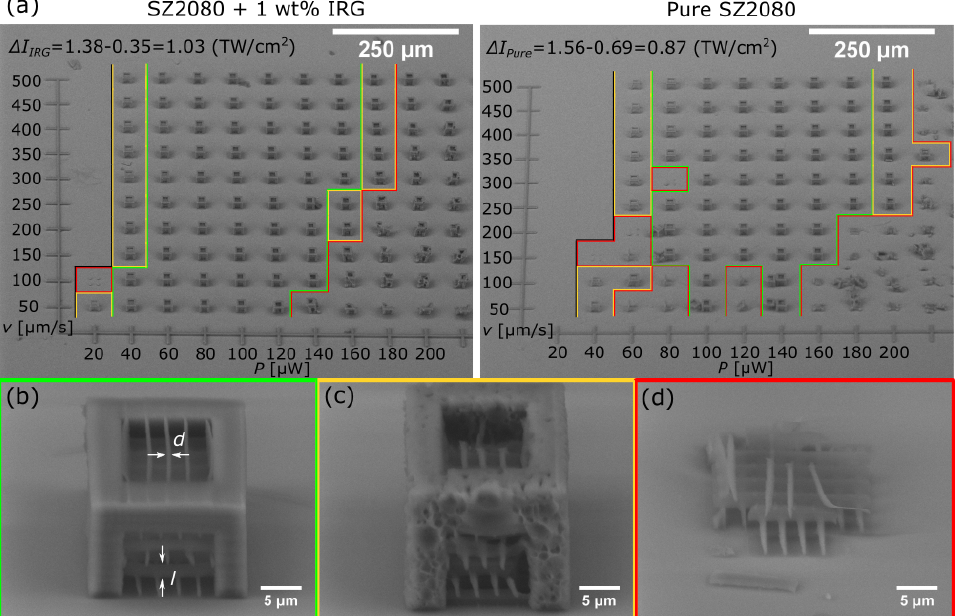
Figure 1. ( a ) SEM images of resolution arrays of photosensitized ( left ) and non-photosensitized ( right ) SZ2080. Structures with severe structural damage ( red ), with poor ( yellow ) and good ( green ) quality are outlined. The structure is considered good if internal single lines are observable and the shape of the cube is as designed. Average laser powers of the bottom and the top of the ∆ I are recalculated to the peak intensity I p (shown at the top); ( b ) one of the good quality structures in the array is shown in a greater detail; l and d marks the longitudinal and transverse sizes of the lines; and ( c ) an example of a poor quality structure and ( d ) the failed one.